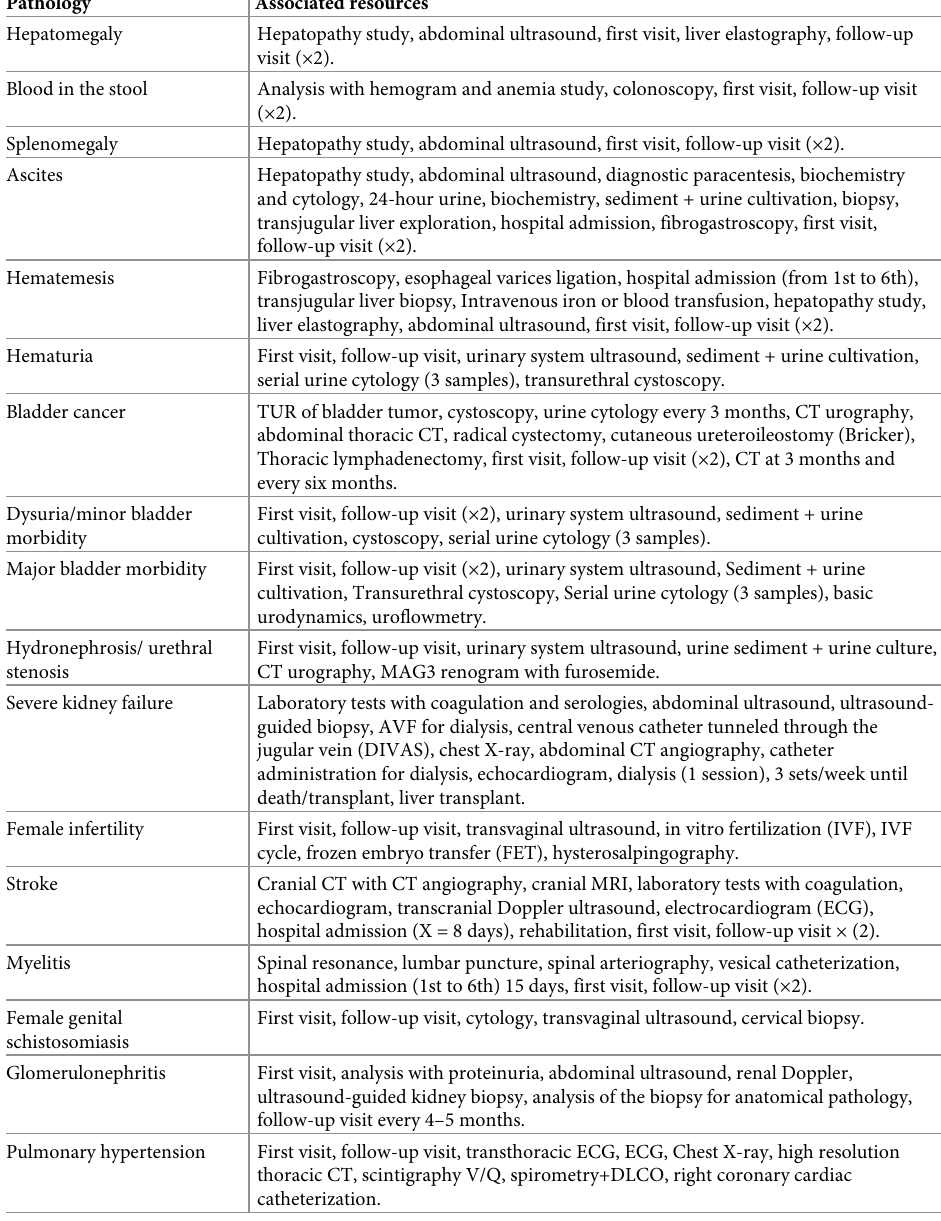
Table 2. Long-term schistosomiasis-associated pathologies and associated care